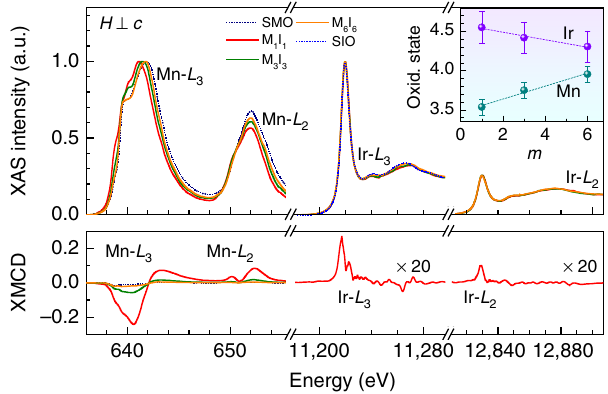
Figure 2 | Elemental-specific charge transfer and interfacial magnetism by XAS and XMCD. The data near the Mn (Ir) edges were obtained at H ¼ 50kOe (40kOe) with H > c after cooling in zero field to 15K (10K). Both ions display a finite XMCD signal, which indicates that both SMO and SIO are ferromagnetically active. The peak near the L 3 edge of Mn (Ir) for the M 1 I 1 sample shifts to lower (higher) energy, indicating a charge transfer from the SIO to the SMO layer. The inset shows the estimate of the oxidation state for each cation determined by a linear interpolation between known positions of Mn and Ir oxidation states, where the uncertainties were determined by propagating the instrumental energy uncertainties into oxidation state